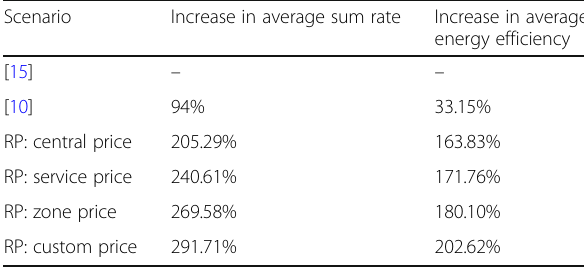
Table 2 Comparative results for average sum rate and